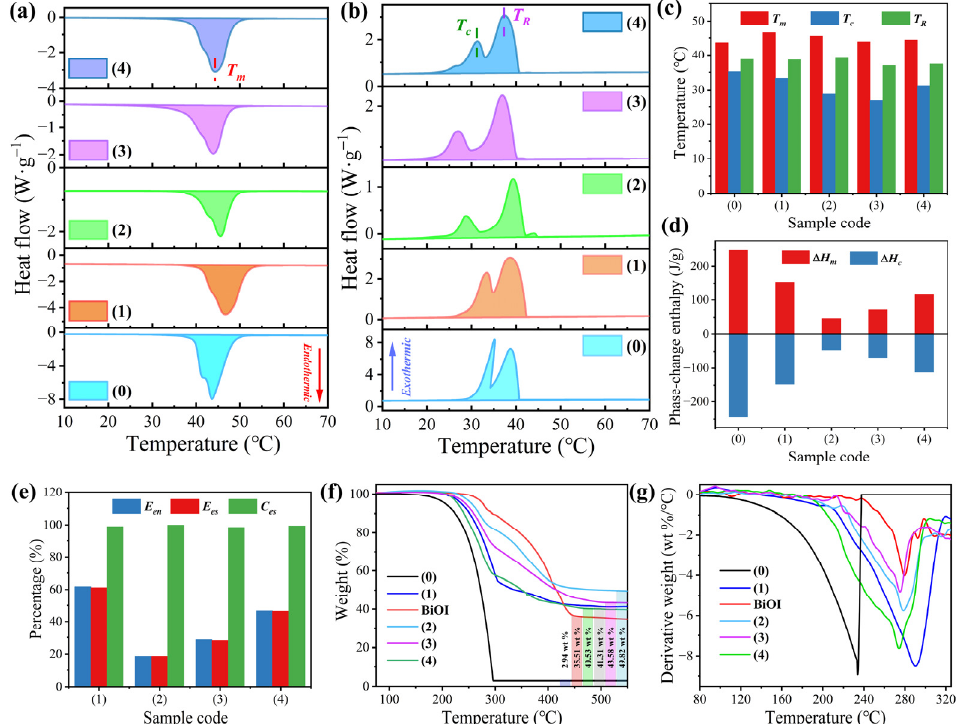
Figure 5. ( a ) Heating and ( b ) cooling DSC thermograms, ( c ) phase-change temperatures, ( d ) phase- change enthalpies, ( e ) encapsulation parameters, ( f ) TGA thermograms, and ( g ) DTG thermograms of (0) pure n -docosane, (1) SiO 2 /Fe 3 O 4 -MEPCM, (2) BiOI-MEPCM (1.5:1), (3) BiOI-MEPCM (1:1), (4) BiOI-MEPCM (0.5:1), and pure BiOI.